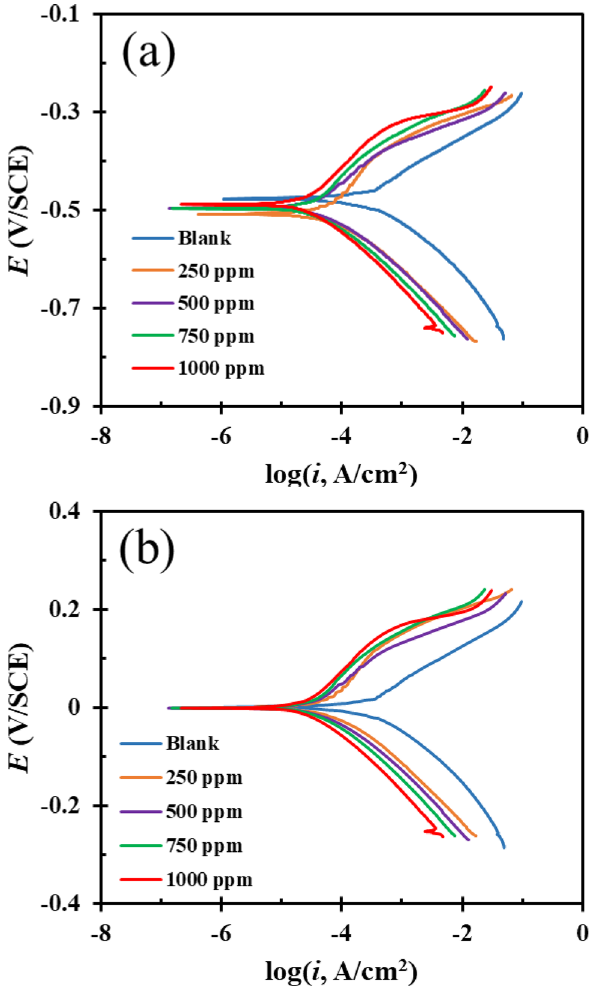
Figure 3. PDP curves after 24 h immersion of MS in 1 M HCl solution without DPH and with different concentrations of DPH at room temperature ( a ) PDP curves shifted to E = 0 ( b ).